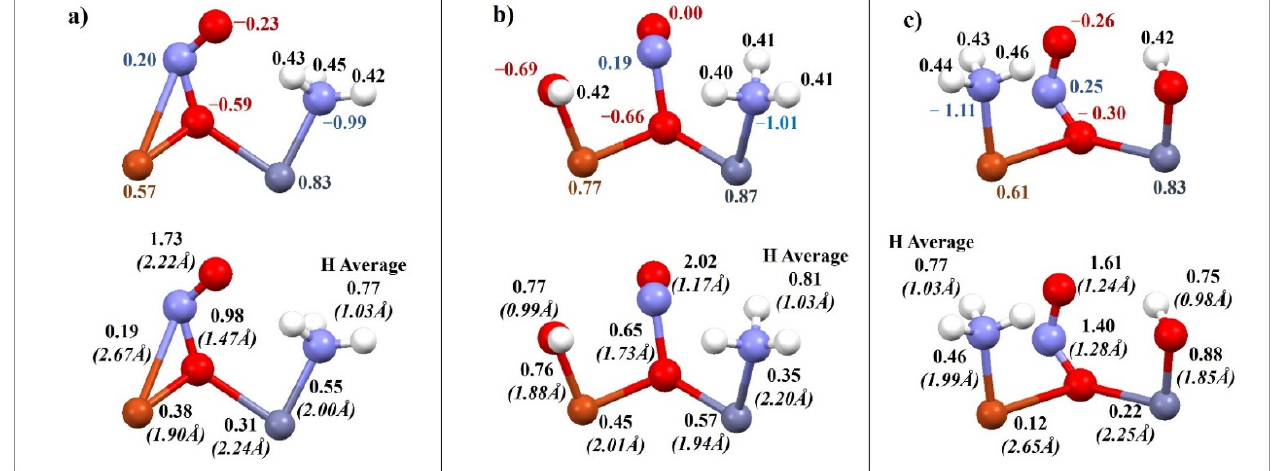
Figure 7. Charge distribution (above), bond order and length—bracketed (below) for coadsorption of NO and NH 3 on metallic Cu–Zn dimers in FAU: ( a ) Cu–Zn bimetallic dimer, ( b ) Cu–Zn bimetallic dimer with OH group on Cu, ( c ) Cu–Zn bimetallic dimer with OH group on Zn.